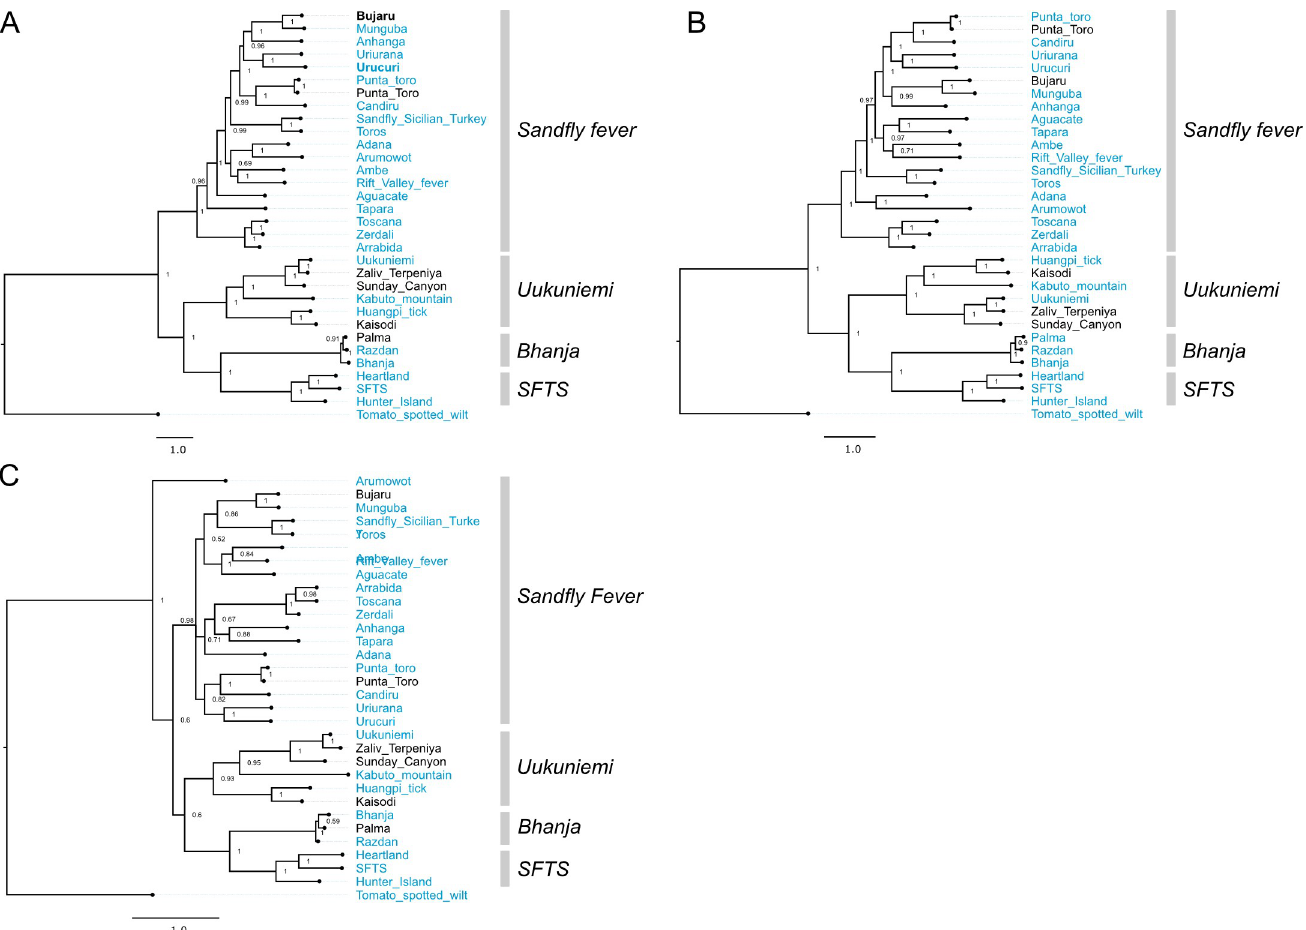
Fig 6. Phylogenetic analysis of viruses in Phenuiviridae . Bayesian phylogenetic tree using (A) the ORF encoding the RdRp on the L segment, (B) the ORF encoding Gn/Gc on the M segment, and (C) the ORF encoding NP on the S segment. Numbers at nodes indicate posterior probability values. Reference sequences are included as phylogenetic landmarks and colored blue. Sequences generated in this study are colored black Classical serogroup distinctions are indicated. Scale bars represent substitutions per site.